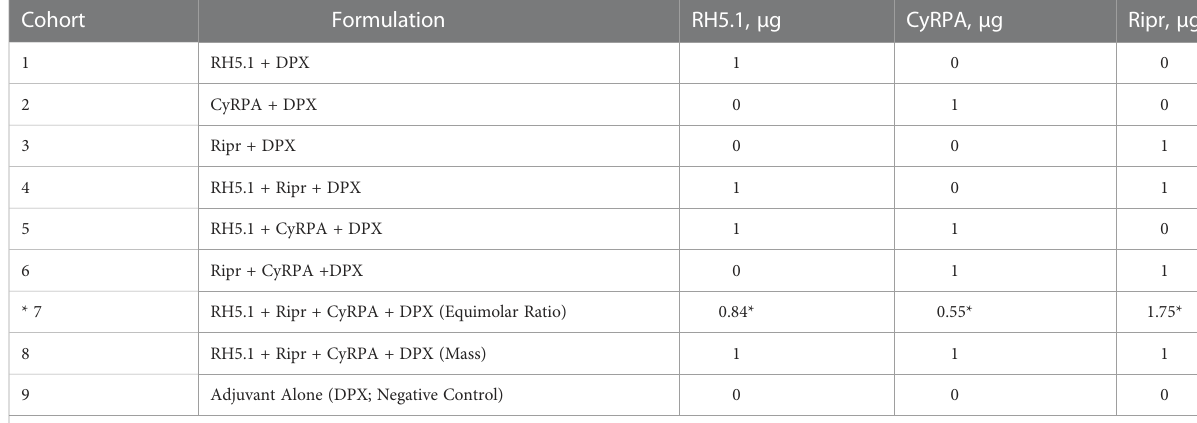
TABLE 1 Single protein and RCR antigen combination dose